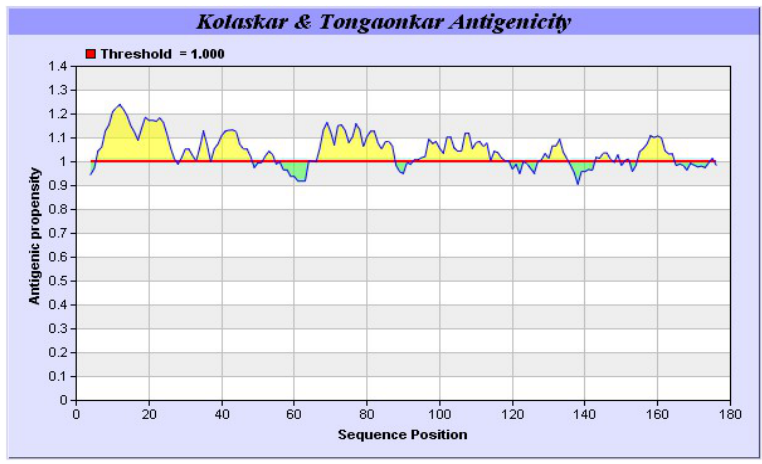
Figure 9. Antigenic properties of yak IGF2 predicted by using Kolaskar and Tongaonkar method. Six potential antigenic peptides having more than 1.0 antigenic propensity and nine or more amino acids in lengths were predicted.